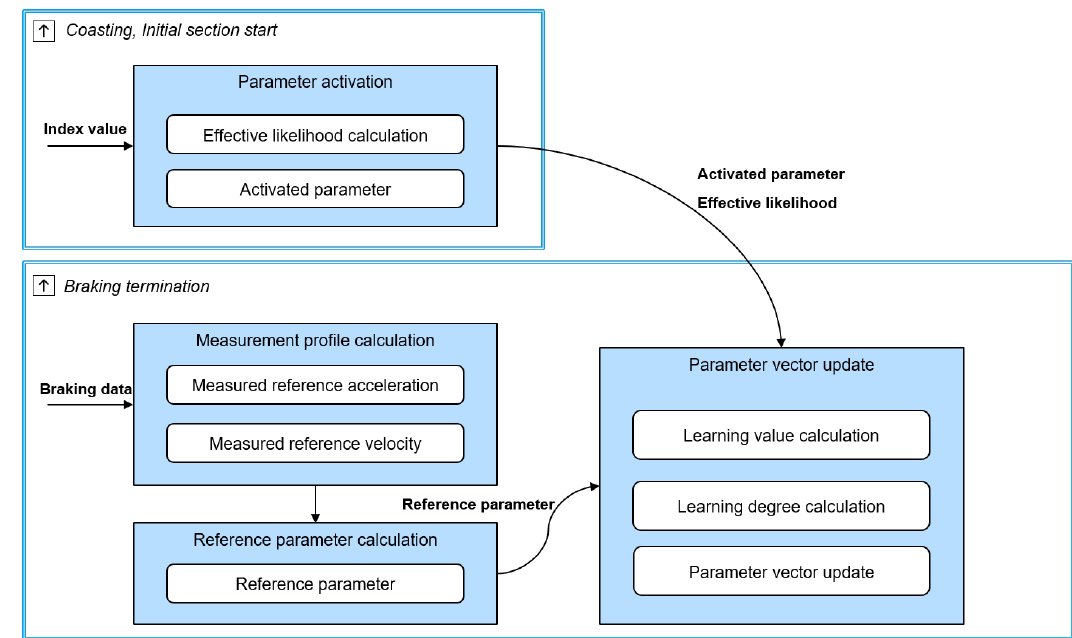
Figure 10. Process of the online learning